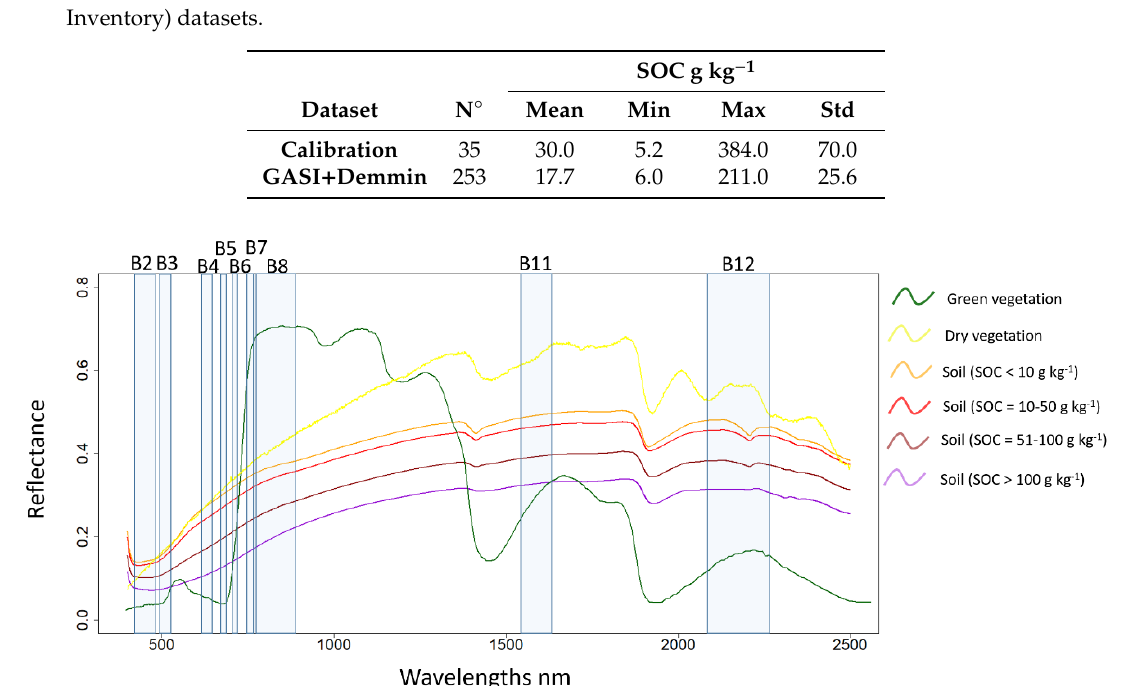
Figure 2. Laboratory soil spectra (400–2500 nm) from LUCAS topsoil database with different organic carbon content compared to dry and green vegetation spectra. The light blue rectangles highlight the spectral position and range of the nine MSI/Sentinel-2 bands used in this work.